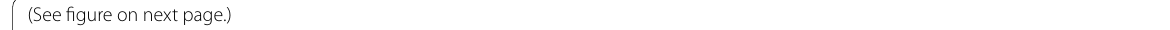
Fig. 5 This section identified the proteins most associated with other proteins. In the sample of patients and healthy individuals with three approaches, we examined the difference in gene expression, gene expression at different stages, and survival. As can be seen in the box plots, the expression of genes is significantly higher in breast cancer patients than in healthy individuals. The same has been confirmed in the stage plot, which shows that the expression of these four genes is high in all the main stages of breast cancer. The survival chart also shows the mortality of people up to 40%, which is the importance of the pathogenicity of these genes in breast cancer, especially in breast cancer stem cells. BRCA